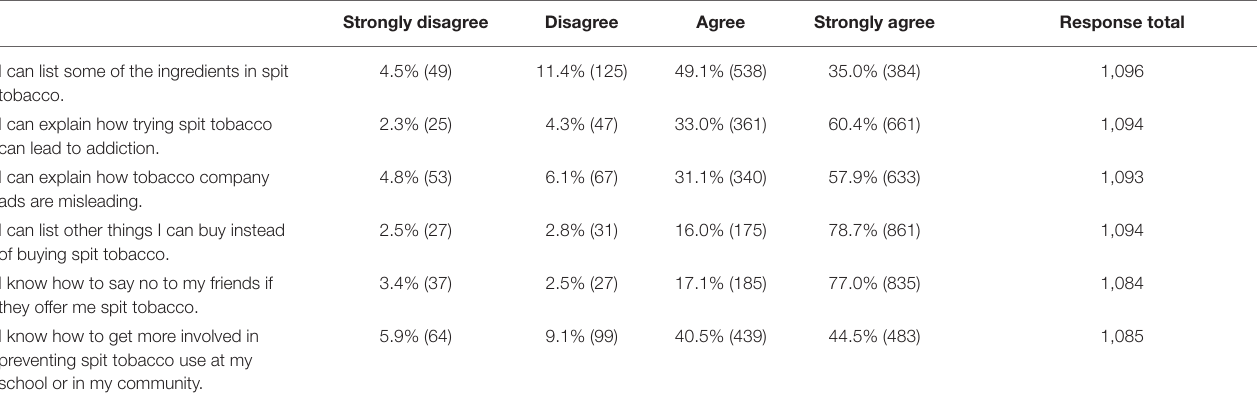
TABLE 2 | Evaluation